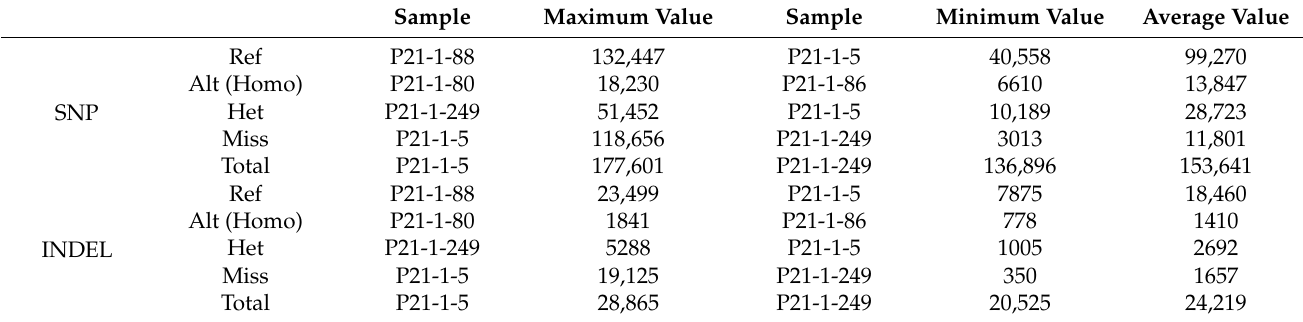
Table 2. Statistics of SNPs and Indels.